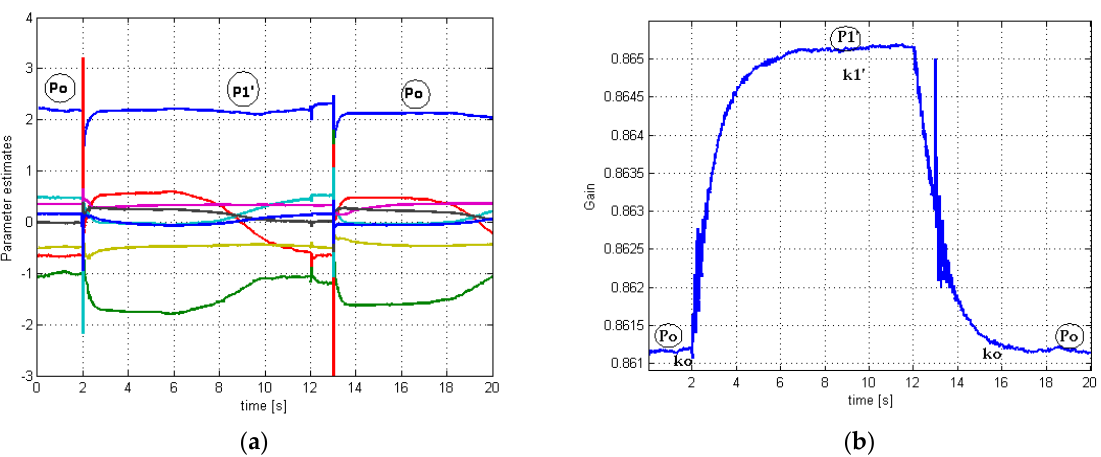
(cid:0) (cid:1) (cid:0) (cid:1) z − 1 z − 1 and B (functioning points: P0-> P1’-> P0); (cid:2886)(cid:3435)(cid:2936) (cid:3127)(cid:3117) (cid:3439) B ( z − 1 ) (functioning points: P0-> P1’-> P0). (functioning points: P0-> P1’-> (cid:2886)(cid:3435)(cid:2936) (cid:3127)(cid:3117) (cid:3439) (cid:2885)((cid:2936) (cid:3127)(cid:3117) ) A ( z − 1 ) (functioning points: P0-> P1’-> P0). (cid:2885)((cid:2936) (cid:3127)(cid:3117) )